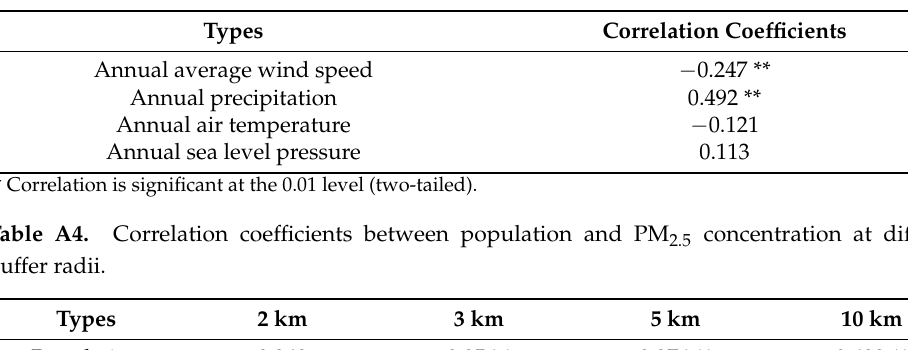
Table A3. Correlation coefficients between meteorology and PM 2.5 concentration.